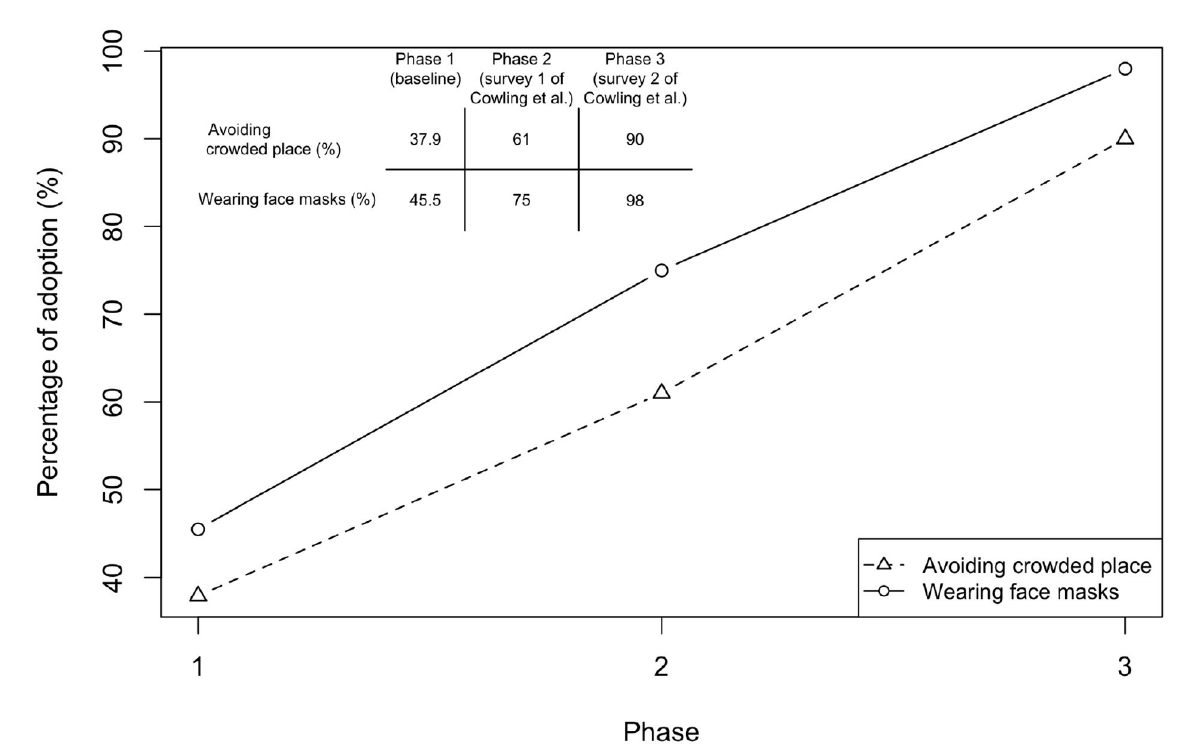
FIGURE4 Changes in behavior in response to COVID-19. Results of Phase 1 were taken from a survey conducted during January 5–February 15, 2020 for assessing the baseline behavior taken to prevent influenza infection. Sample size is 66, with 45 females. Respondents were aged between 19 and 64. Three respondents have taken flu vaccination. Note that the survey questions only ask the possible measures in order to prevent influenza but not COVID-19. Hence, the results indicate the baseline behavior before COVID-19 emerged (Avoiding crowded places: 37.9%, 95%CI, 26.2–49.6%; Wearing face masks: 45.5%, 95%CI, 33.5–57.5%). Results of Phases 2 (Cowling Survey 1) and 3 (Cowling Survey 2) were taken from a previous study conducted by Cowling et al. (16)) before NPIs were implemented in Hong Kong. Cowling Survey 1 (January 20-23)